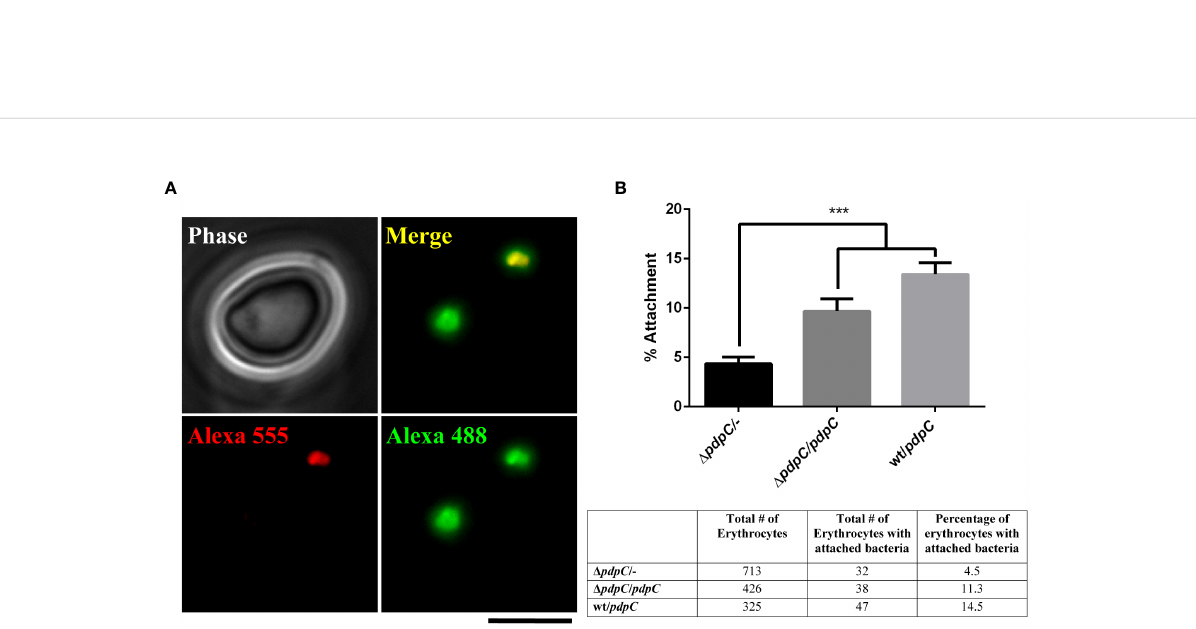
FIGURE 3 PdpC is required for ef fi cient attachment to erythrocytes. F. tularensis strains were incubated with 1x 10 6 human erythrocytes at an MOI ~100 for 2 hours. Cells were pelleted, washed and DIF microscopy was used determine the number erythrocytes with attached bacteria. (A) An example of DIF microscopy. A red blood cell incubated with wt F. tularensis LVS containing a complementation plasmid. Bacterial cells attached to the surface are labeled with both red and green secondary antibodies. A bacterial cell that has invaded the red blood cell is labelled only in green. The scale bar represents 5 µm. (B) Dual labeled erythrocytes were scored for the presence of at least one attached F. tularensis LVS cell. The mean percentage of erythrocytes with attached bacteria is shown. Signi fi cantly fewer erythrocytes with attached bacteria were seen in the samples incubated with the pdpC -null mutant containing an empty vector than either the pdpC -null mutant containing a complementation vector with a copy of pdpC under the control of the strong groEp promoter, or the wild type containing the same complementation vector (*** p > 0.001 determined by 1-way ordinary ANOVA with Tukey ’ s multiple comparisons test). The averages of 3 biological replicates, ± the standard error, are shown. For each experimental condition at least 325 erythrocytes were scored in total for attachment of bacteria and the total number of erythrocytes scored is shown in the table.